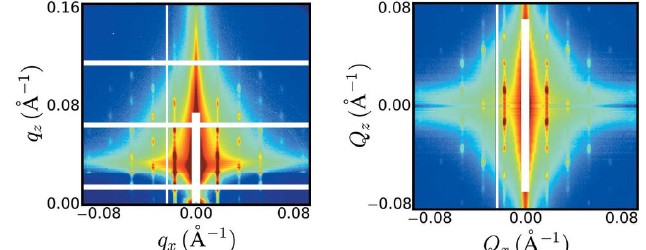
Figure 1 Correcting X-ray vision of thin films: the unwarping algorithm by Liu and Yager takes experimental GISAXS data (left), and generates a corresponding SAXS pattern (right). [Figure adapted from Liu & Yager (2018) with